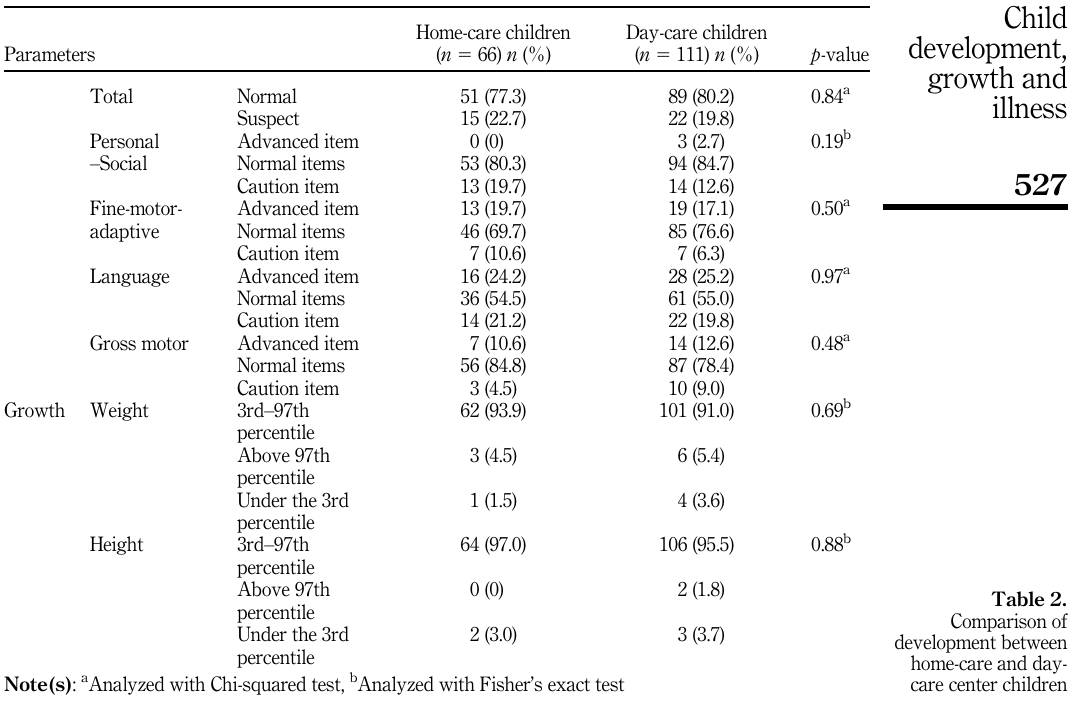
Table 2. Comparison